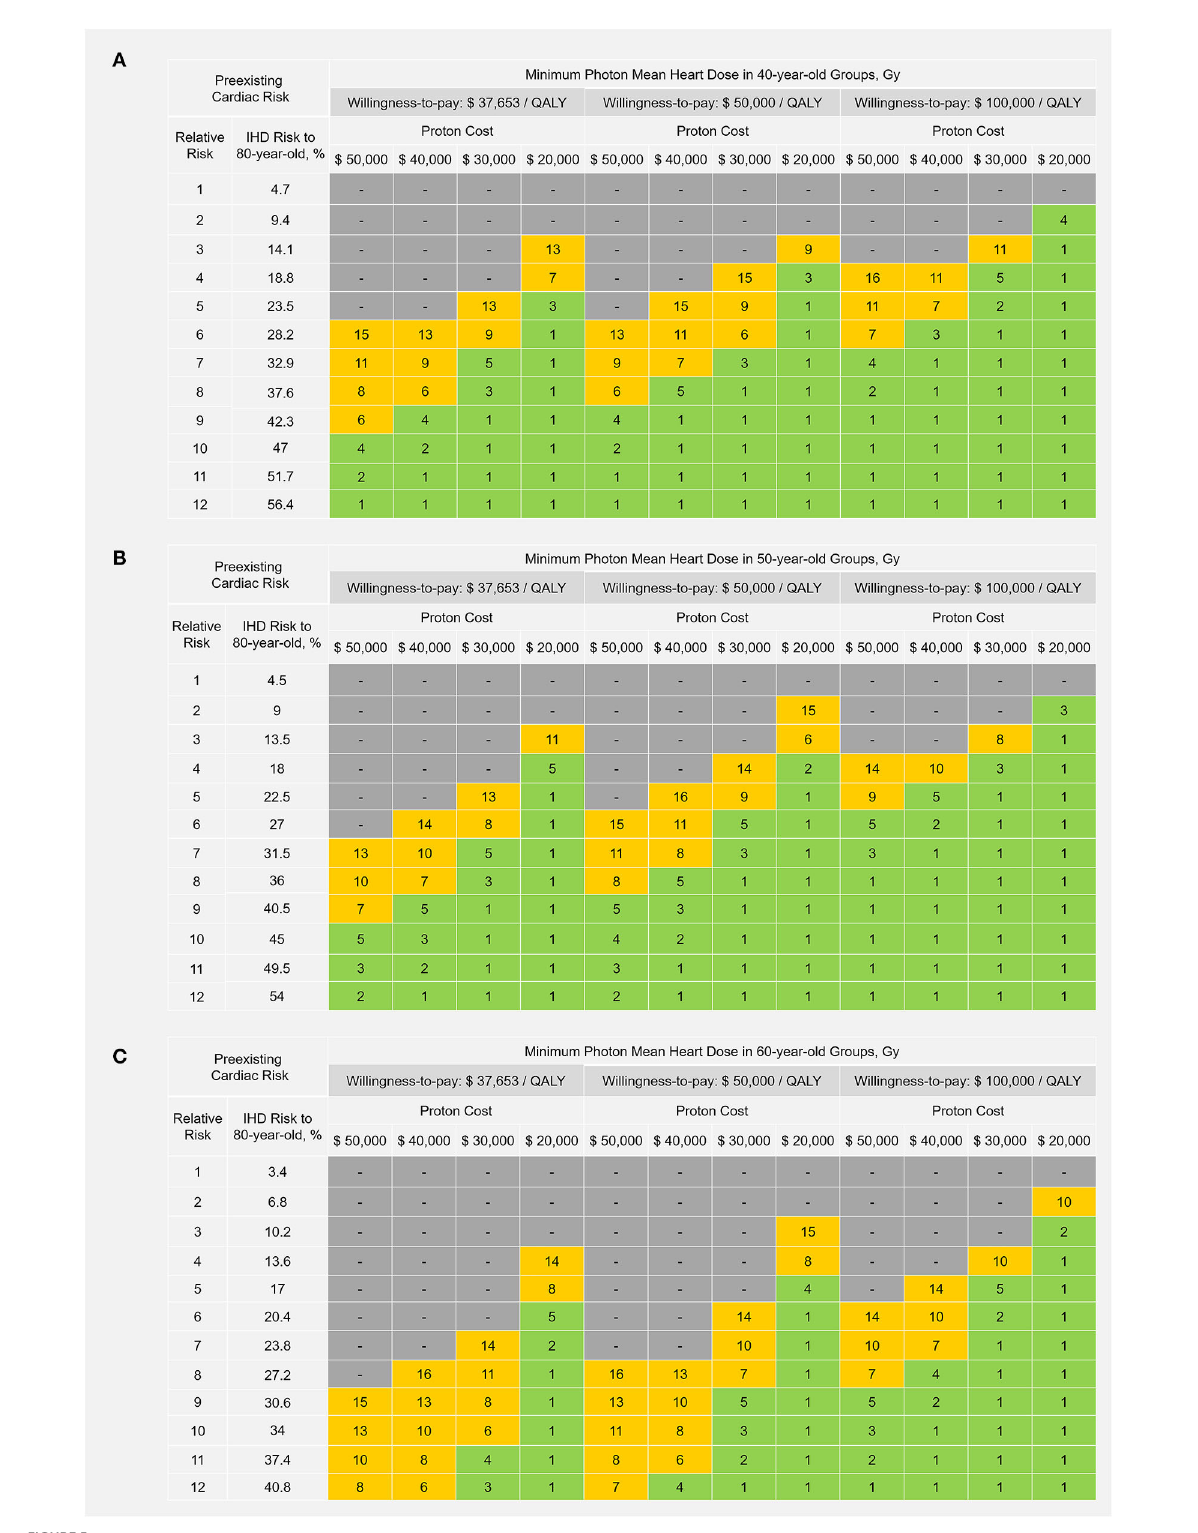
FIGURE5 Cost-effective thresholds of photon mean heart dose in (A) 40-year-old. (B) 50-year-old; and (C) 60-year-old patients. Protons could be considered cost-effective to a patient if the estimated photon mean heart dose is ≥ the corresponding threshold value shown in the table. Green regions represent the photon mean heart dose range of 1–5 Gray (Gy); yellow regions represent the photon mean heart dose range of 6–16Gy; and gray regions represent “not cost-effective” (the required minimum photon mean heart dose > 16Gy). $, US dollars; QALY, quality-adjusted life-year; IHD, ischemic heart